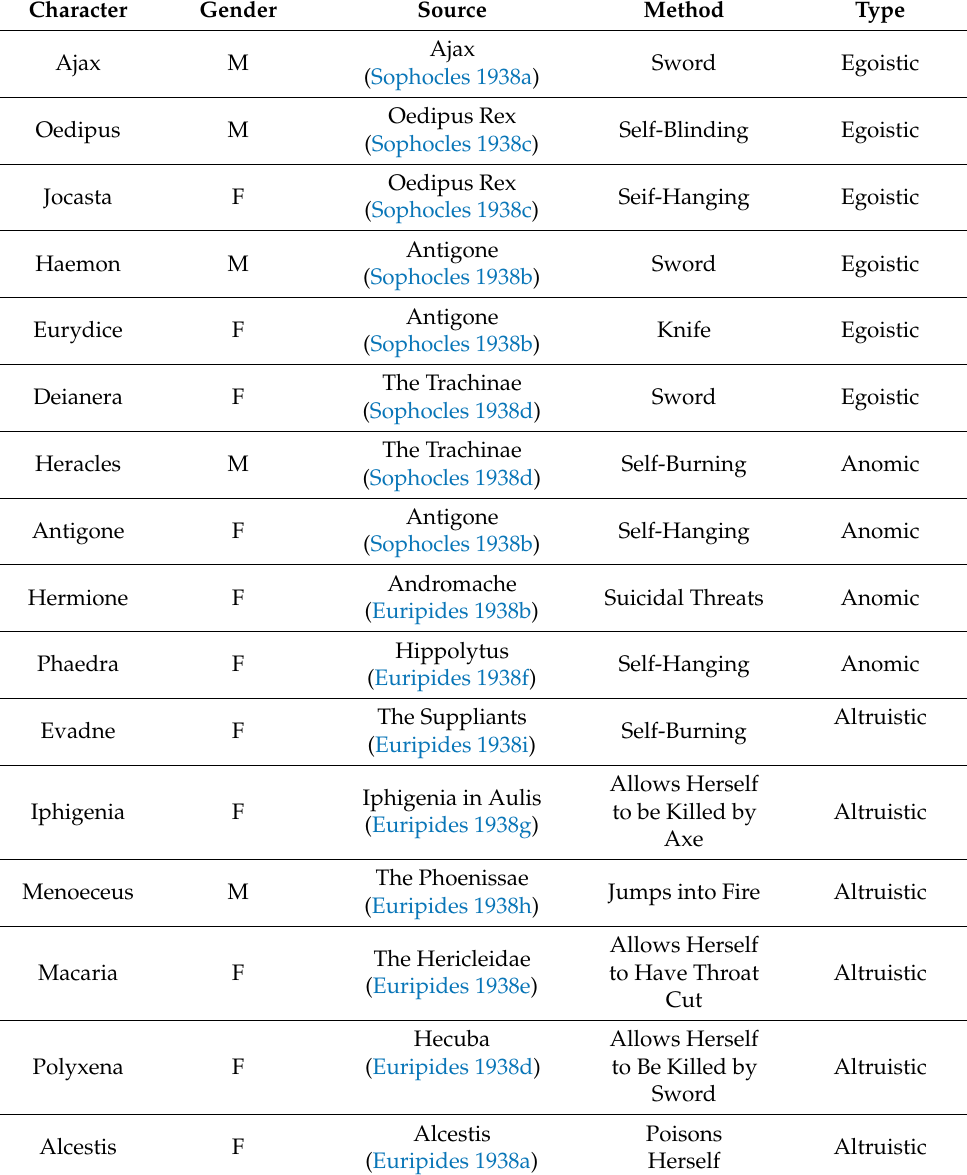
Table 1. Suicides in Greek